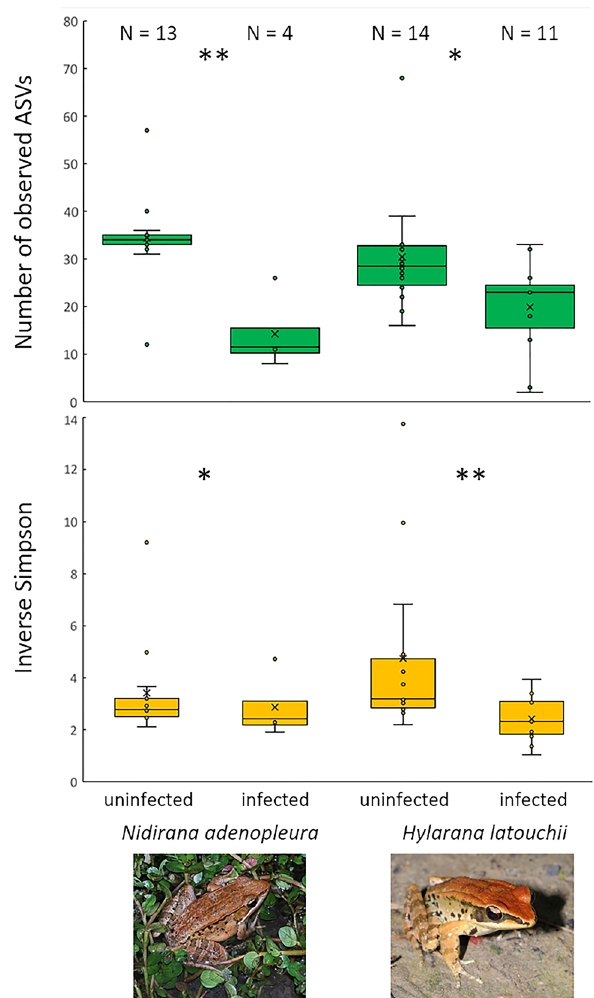
richness (N ASVs , N. adenopleura : U 16 = 50.5, p = 0.003, H. latouchii : U 24 = 116, p = 0.031) and evenness (Inverse Simpson, N. adenopleura :